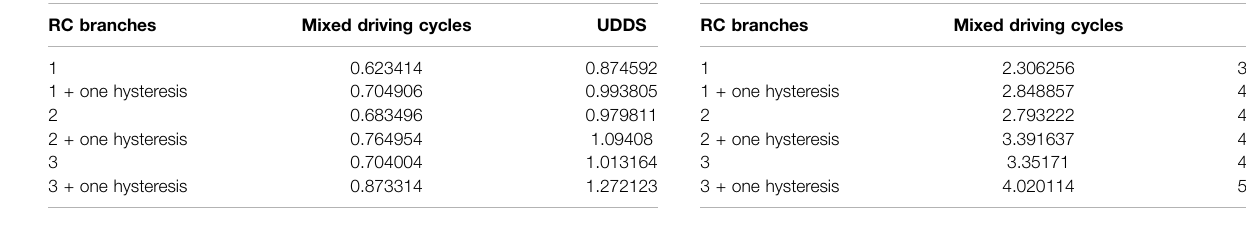
TABLE 7 | Time consuming of ACKF with varying RC